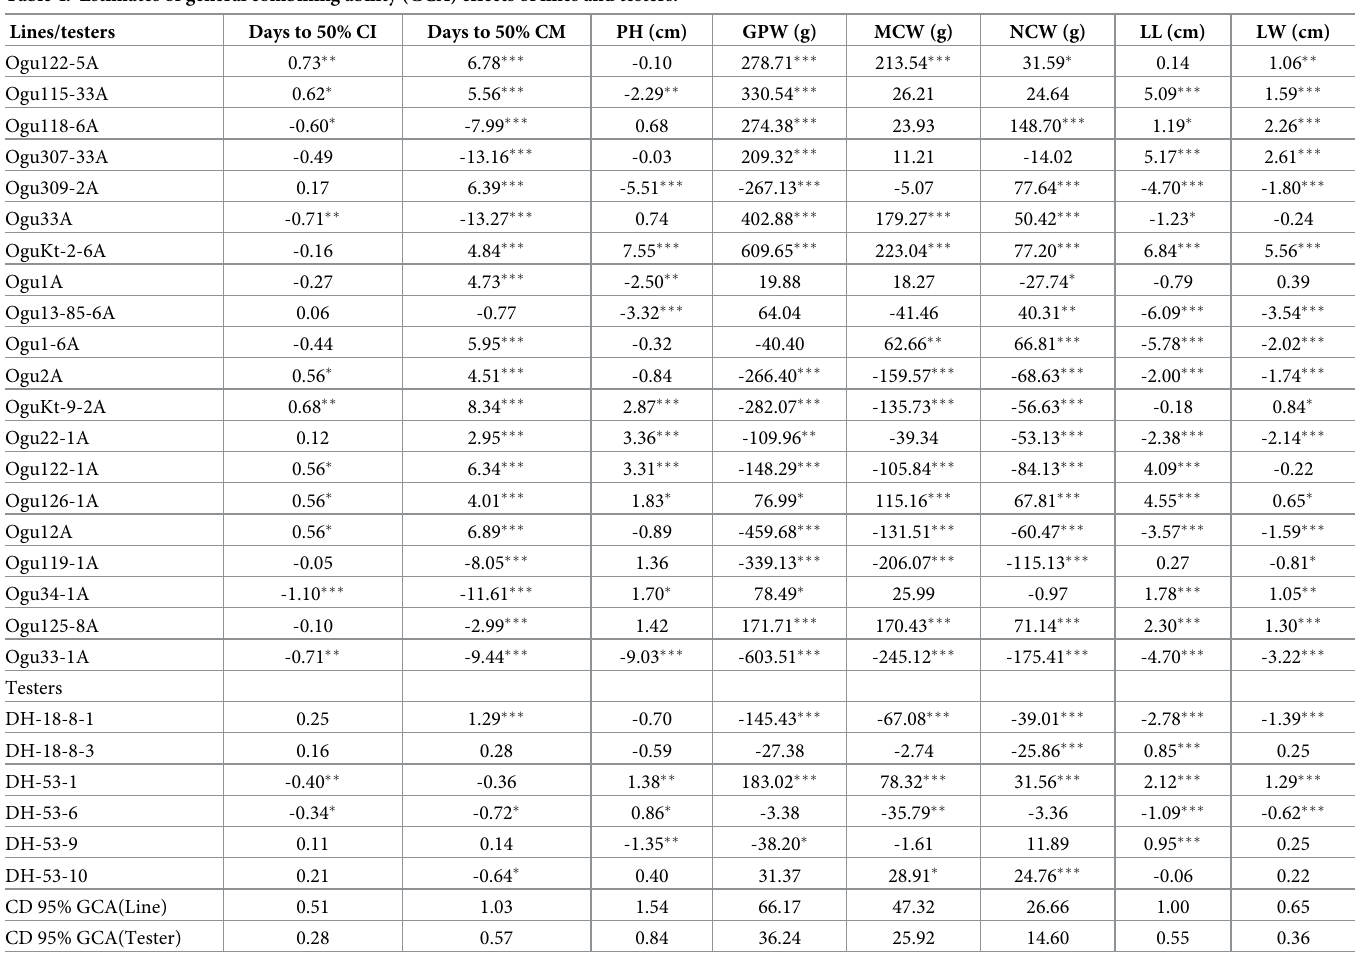
Table 4. Estimates of general combining ability (GCA) effects of lines and